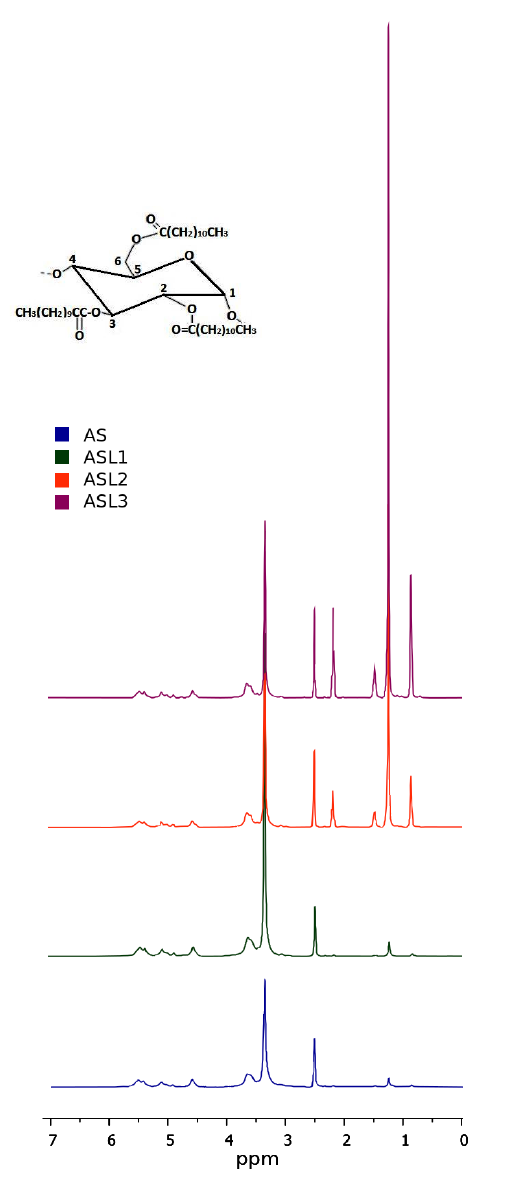
Figure 1. 1 H NMR spectra of native (AS) and modified amaranth starches (ASL1, ASL2 and